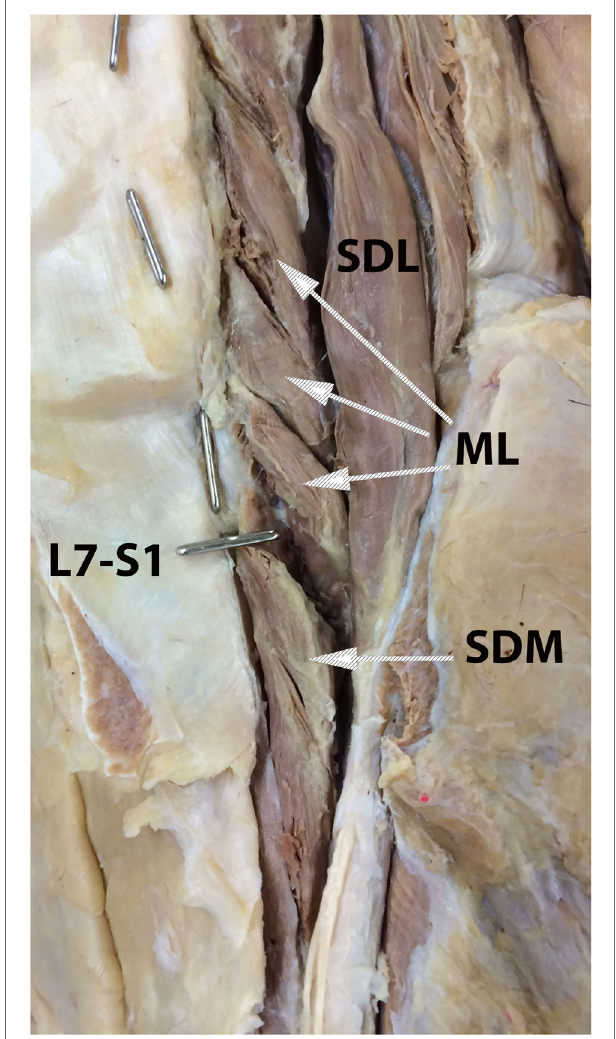
FIGURe 1 | Anatomic dissection photograph illustrating identification of the multifidus lumborum (ML), sacrocaudalis dorsalis medialis (sdM), and sacrocaudalis dorsalis lateralis (sdL) muscles . Cranial is at the top of the image and the dog’s right is on the viewer’s right. Metal pins oriented in the sagittal plane mark the L7 and L6 spinous processes. The metal pin oriented in the transverse plane marks the L7–S1 junction. Attaching near the summit of the L7 spinous process is the SDM muscle bundle that continues caudally into the sacral region and on caudally, along with other muscle bundles into the tail region. This is the so-called short elevator of the tail. A longer muscle than is the SDM, the SDL originates as far craniad as from the cranial lumbar vertebrae and continues caudally into the sacral and tail regions. This muscle, which serves as the so-called long elevator of the tail, is readily dissectable as separate from the longissumus lumborum.